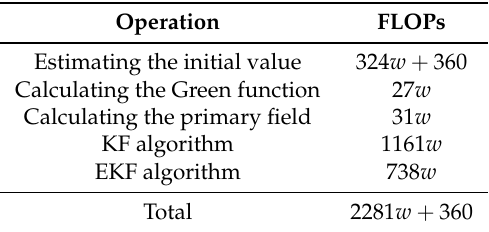
Table 6. FLOPs of IVE-KF algorithm.